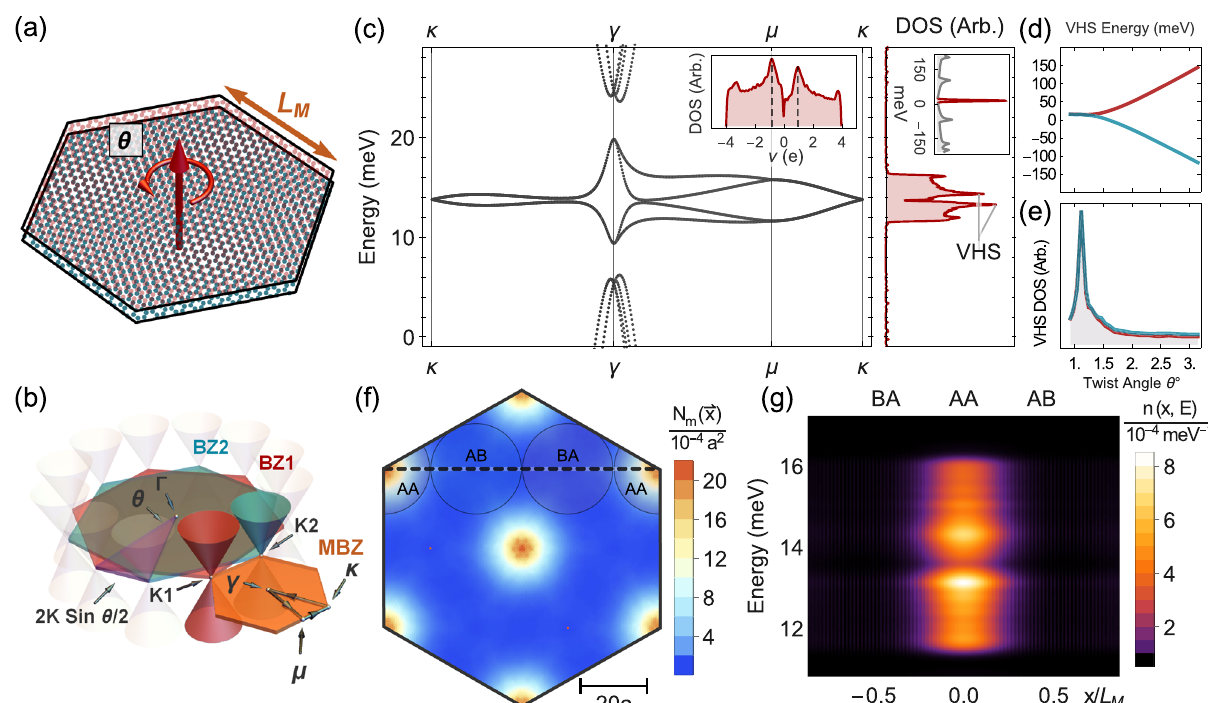
Fig. 1 Lattice structure and normal state properties of twisted bilayer graphene (TBG). a Carbon lattice in one moiré cell of TBG with twist angle θ ≈ 3.9 ∘ and moiré period L M . b Illustration of TBG in reciprocal space, where θ rotates the two hexagonal Brillouin zones (BZ) of the graphene layers (BZ1 and BZ2), displacing the Dirac cones at the BZ corners (K1 and K2) by Δ K ¼ 2 K sin ð θ = 2 Þ , the reciprocal length of the moiré Brillouin zone (MBZ). Depicted are also the high symmetry lines and points ( γ , μ , κ ) in the MBZ. c Low-energy band structure of TBG at θ ≈ 1.2 ∘ along the high symmetry lines in b , consisting of four narrow spin-degenerate moiré bands (solid lines) separated from other bands (dotted lines) by fi nite energy gaps. The corresponding large density of states (DOS), peaking at the upper and lower van Hove singularities (VHSs), is plotted on same energy axis to the right. Side inset: DOS for a larger energy range, highlighting the massive moiré fl at band (red) DOS peak. Inset: DOS as a function of the moiré band fi lling factor ν in units of electrons per moiré unit cell with VHSs at ν ≈ ± 1 (dashed lines). d Energy of the upper and lower VHSs as a function of twist angle θ . e Maximum peak height of the two VHS peaks as a function twist angle θ , peaking sharply at the magic angle. f Intensity plot of the top layer charge density N m ( x ) of the completely fi lled moiré bands, equivalent to integrating the LDOS in g . The scale bar shows a distance of 20 a , where a = 2.46 Å is the graphene lattice constant. g Local density of states (LDOS) n ( x , E ) as a function of energy E and position along the dashed line in f , centered on the AA